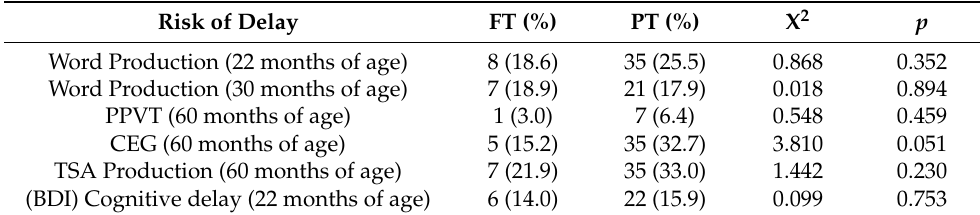
Table 5. Frequency and (percentage) of PT and FT children with language delay at 22, 30 and 60 months of age (<10th percentile), and with of cognitive delay (<15th percentile) at 22 months of age and comparisons between